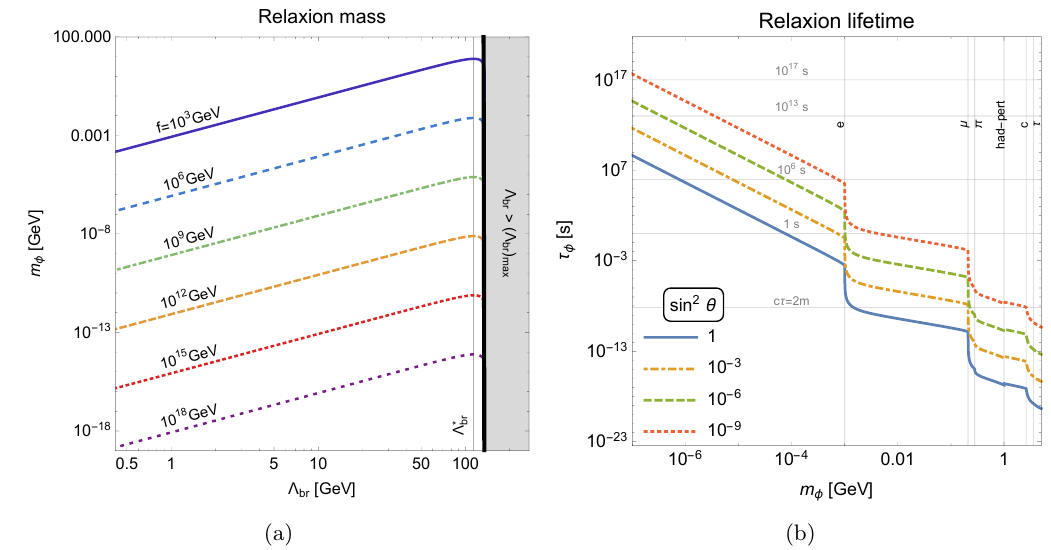
Figure 1 . Relaxion properties: (a) The relaxion mass m (cid:30) as a function of (cid:3) br for di(cid:11)erent values of f , where the vertical gray line indicates (cid:3) (cid:3)